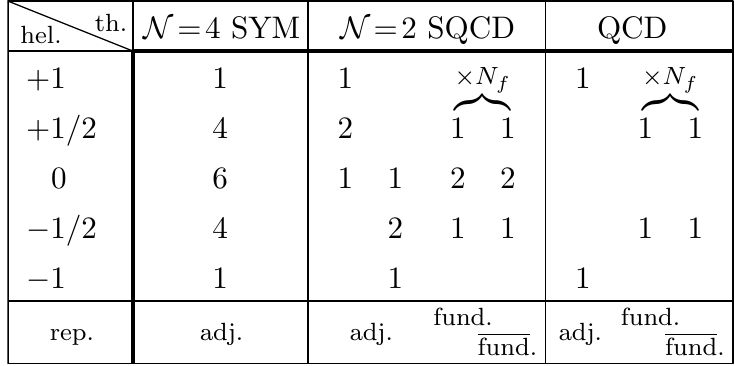
Table 1 . On-shell states of = 2 SQCD in comparison with N massless QCD. The helicities are listed in the left column, and SU( N c )-group representations of the particles are shown in the lower